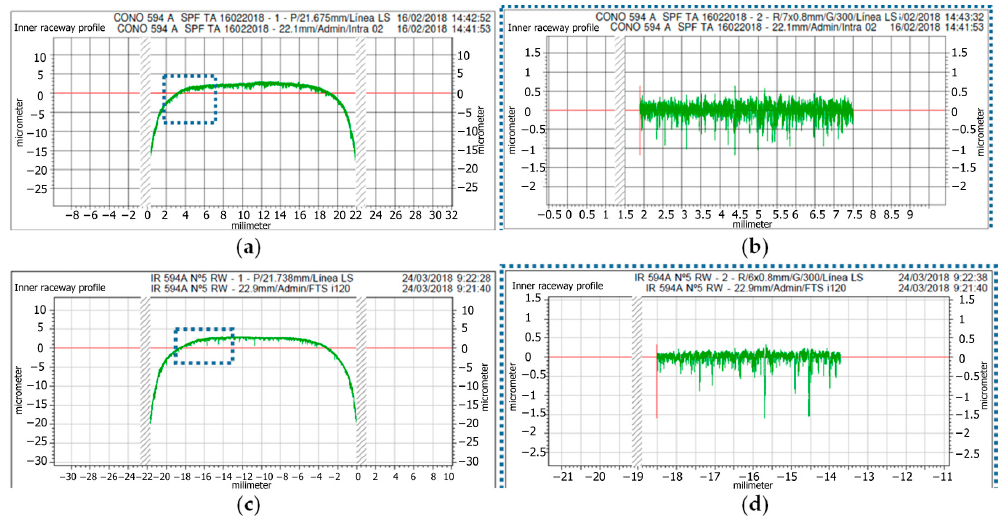
Figure 4. Inner raceway profile (logarithmic) for ( a ) Uncoated bearing; ( b ) uncoated bearing at the selected area in ( a ), ( c ) coated bearing; and ( d ) coated bearing at the selected area in ( c ).